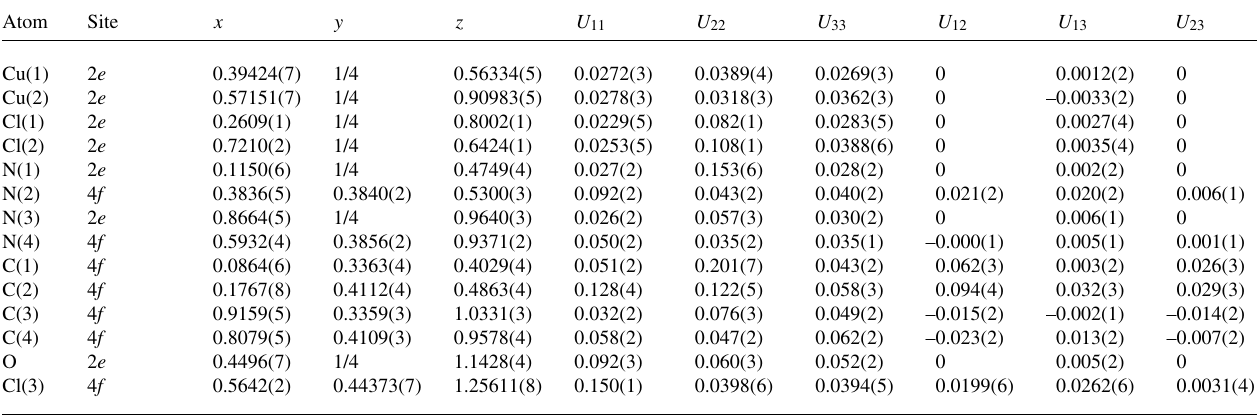
Table 3. Atomic coordinates and displacement parameters (in Å 2 ) .